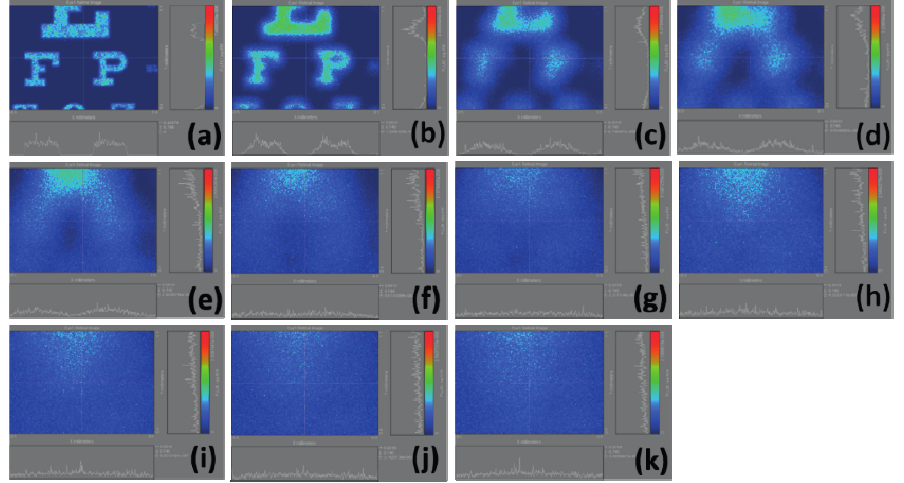
Figure 7. Calculation results of retinal images by selecting the whole Snellen chart in Figure 3(d); ( a ) plano; ( b )1.00 D; ( c ) 2.00 D; ( d ) 3.00 D; ( e ) 4.00 D; ( f ) 5.00 D; ( g ) 6.00 D; ( h ) 7.00 D; ( i ) 8.00 D; ( j ) 9.00 D; ( k ) 10.00